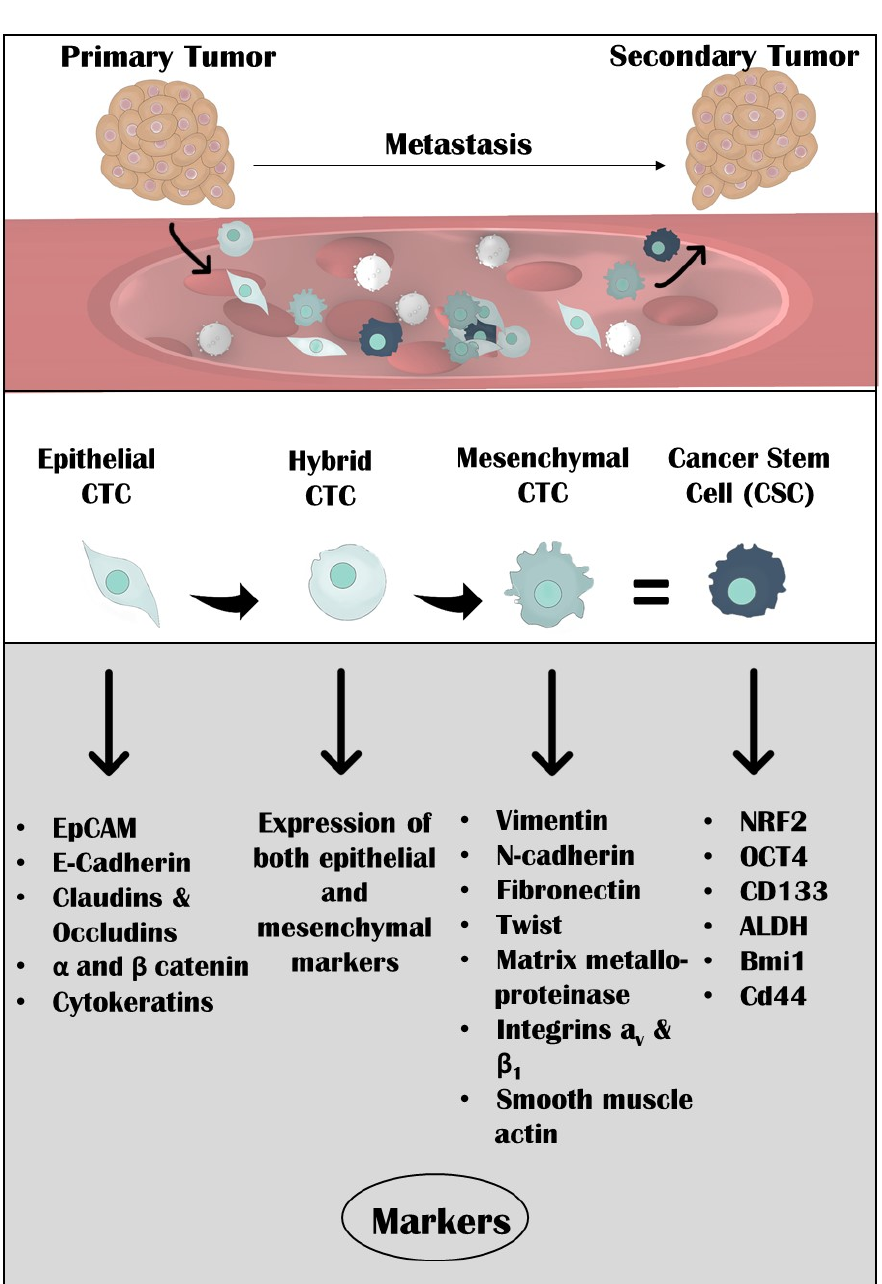
Figure 1. Mesenchymal and stem features in lung cancer patients.